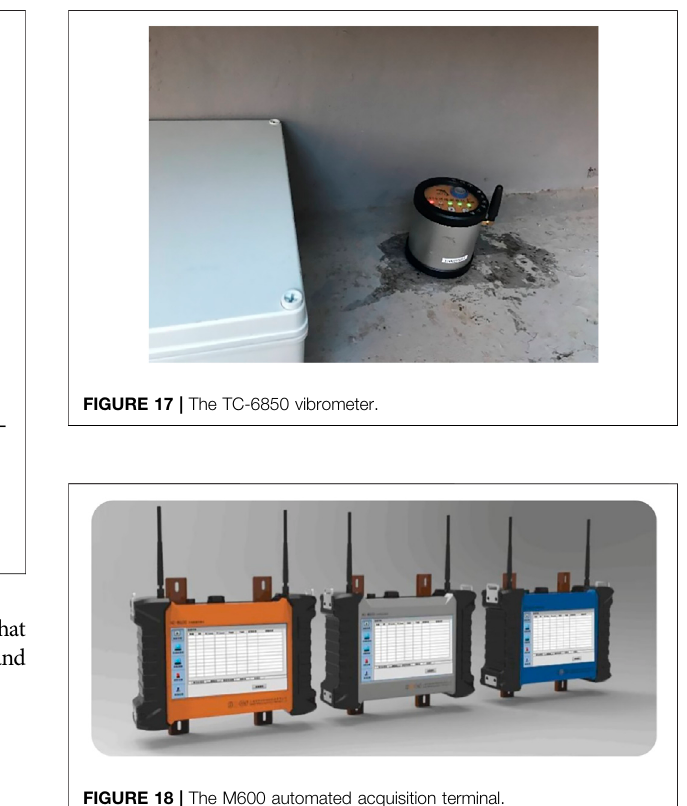
FIGURE 18 | The M600 automated acquisition